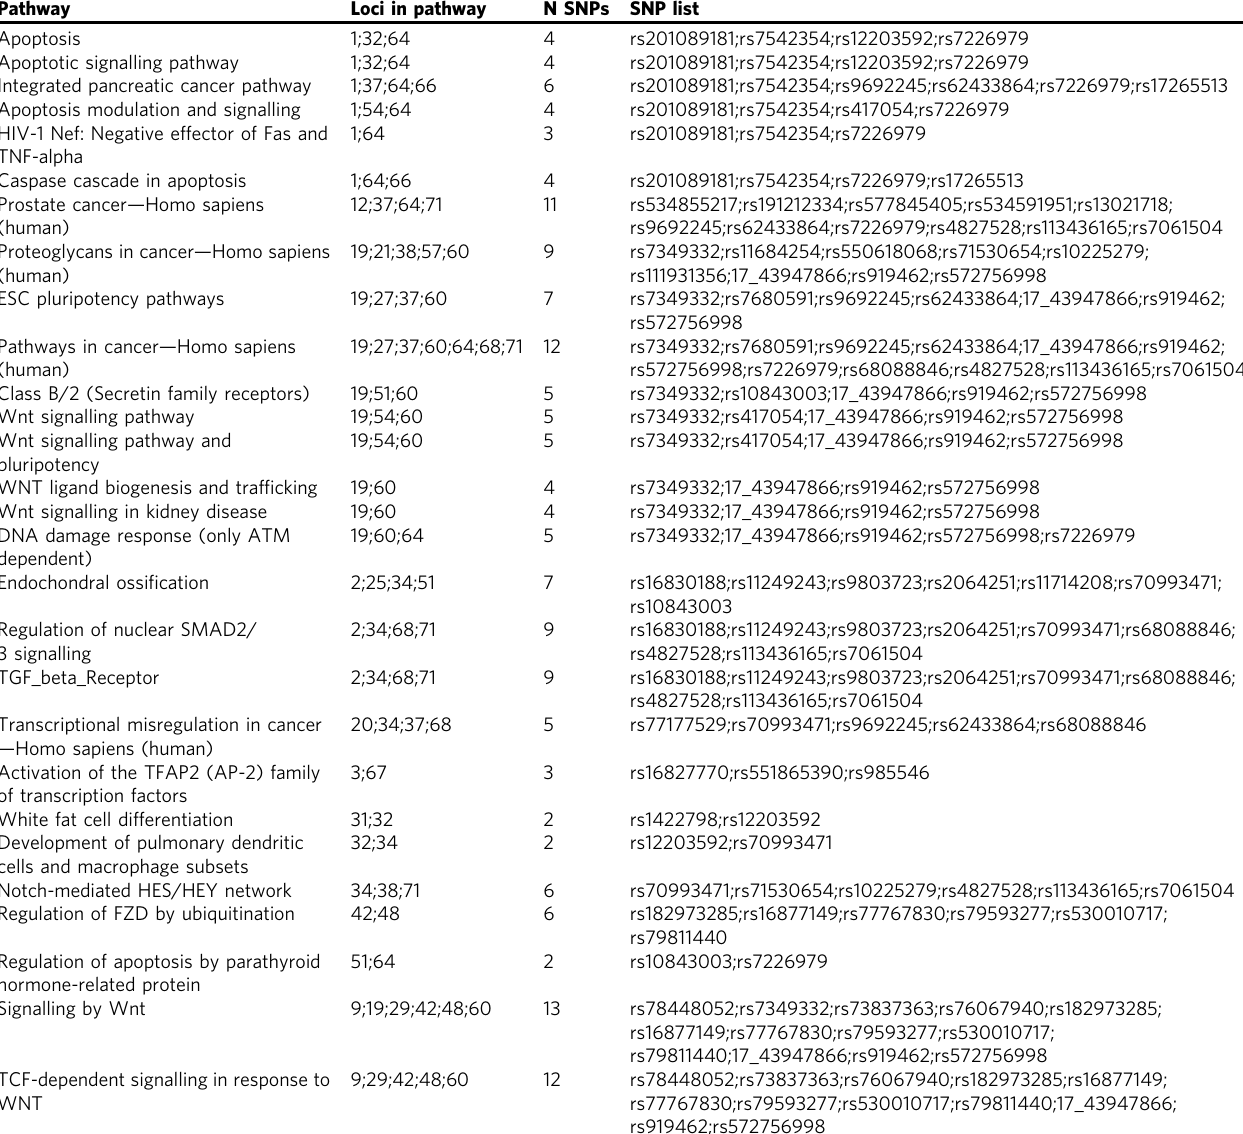
Table 2 Pathways used to generate pathway polygenic risk scores Pathway Loci in